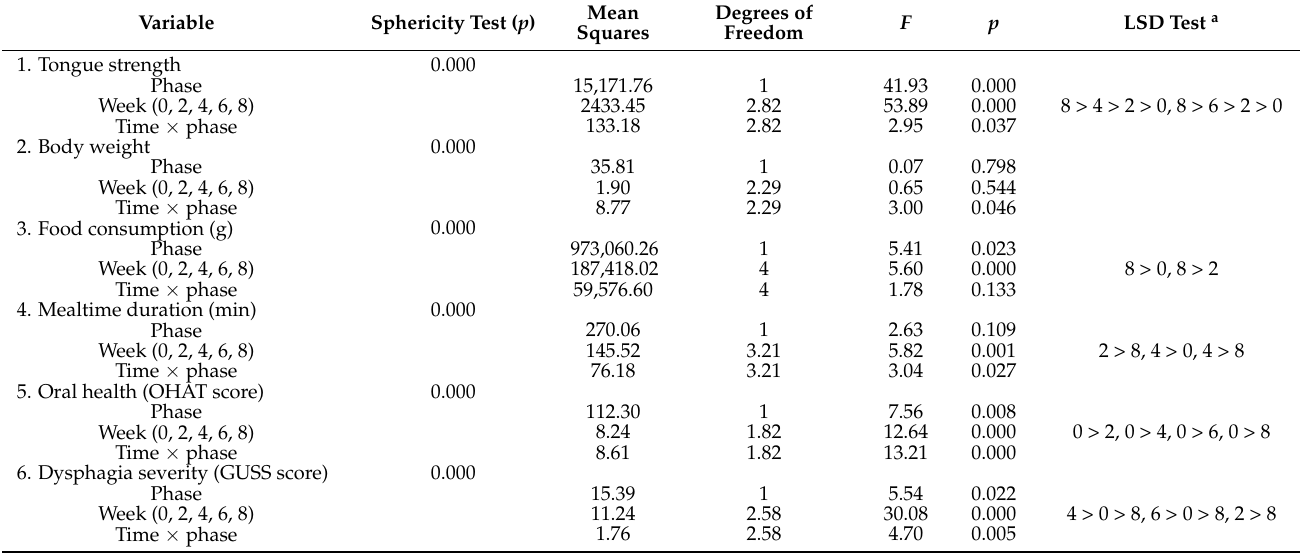
Table 5. Effects of multifaceted intervention program.